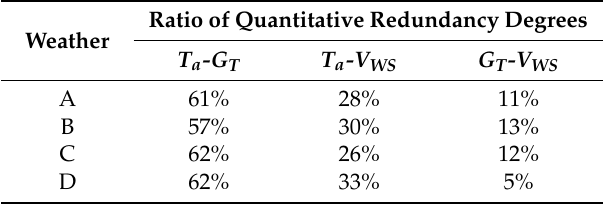
Table 12. Ratio of quantitative redundancy degrees between